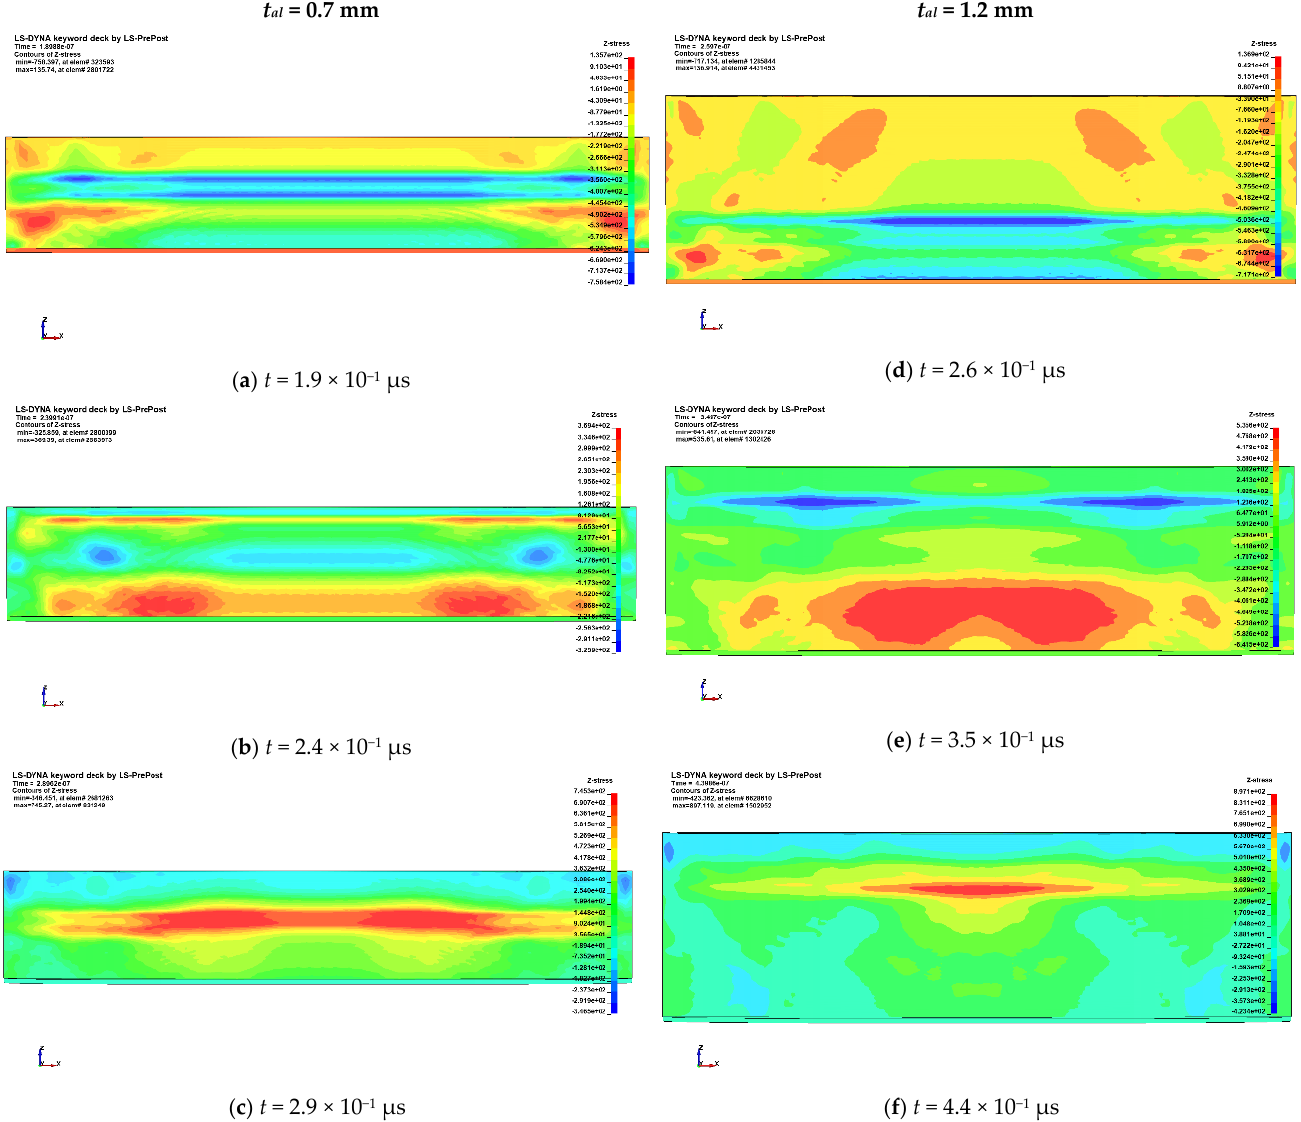
Figure 12. Evolution of σ z stresses in the aluminum substrate for t al = 0.7 mm ( a – c ), and for t al = 1.2 mm ( d – f